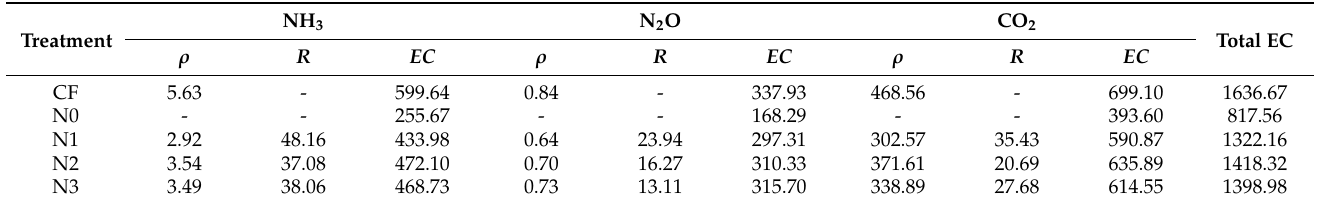
Table 2. NH 3 , N 2 O and CO 2 average emission rates ( ρ , %), emission reduction rate ( R , %), environment cost ( EC , CNY ha − 1 ) under different treatments and total environment cost (Total EC, CNY ha − 1 ).